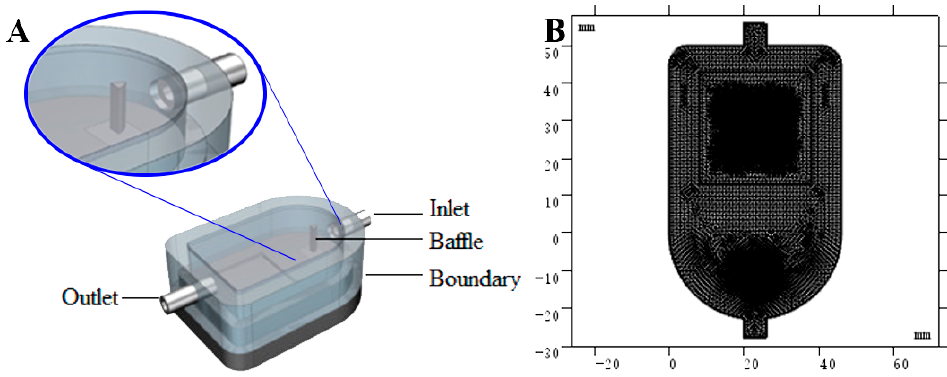
Figure 2. Design of reaction chamber. ( A ) Design of reaction chamber in 3D; ( B ) Grid generation in 2D.